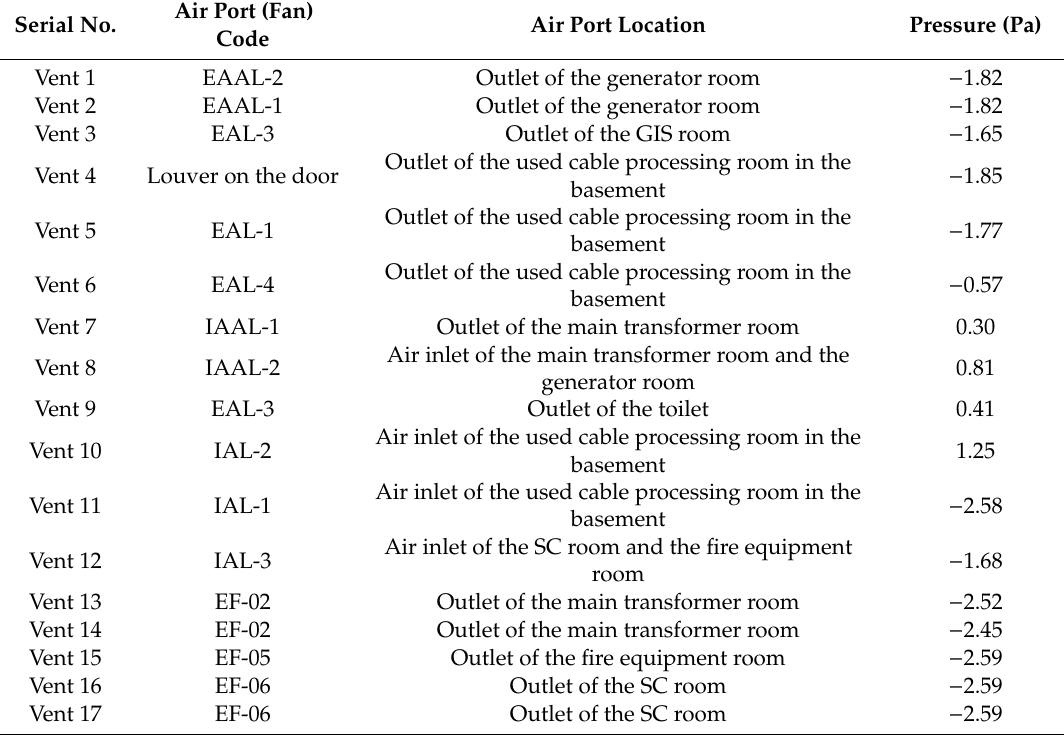
Table 7. Building vent pressure calculation